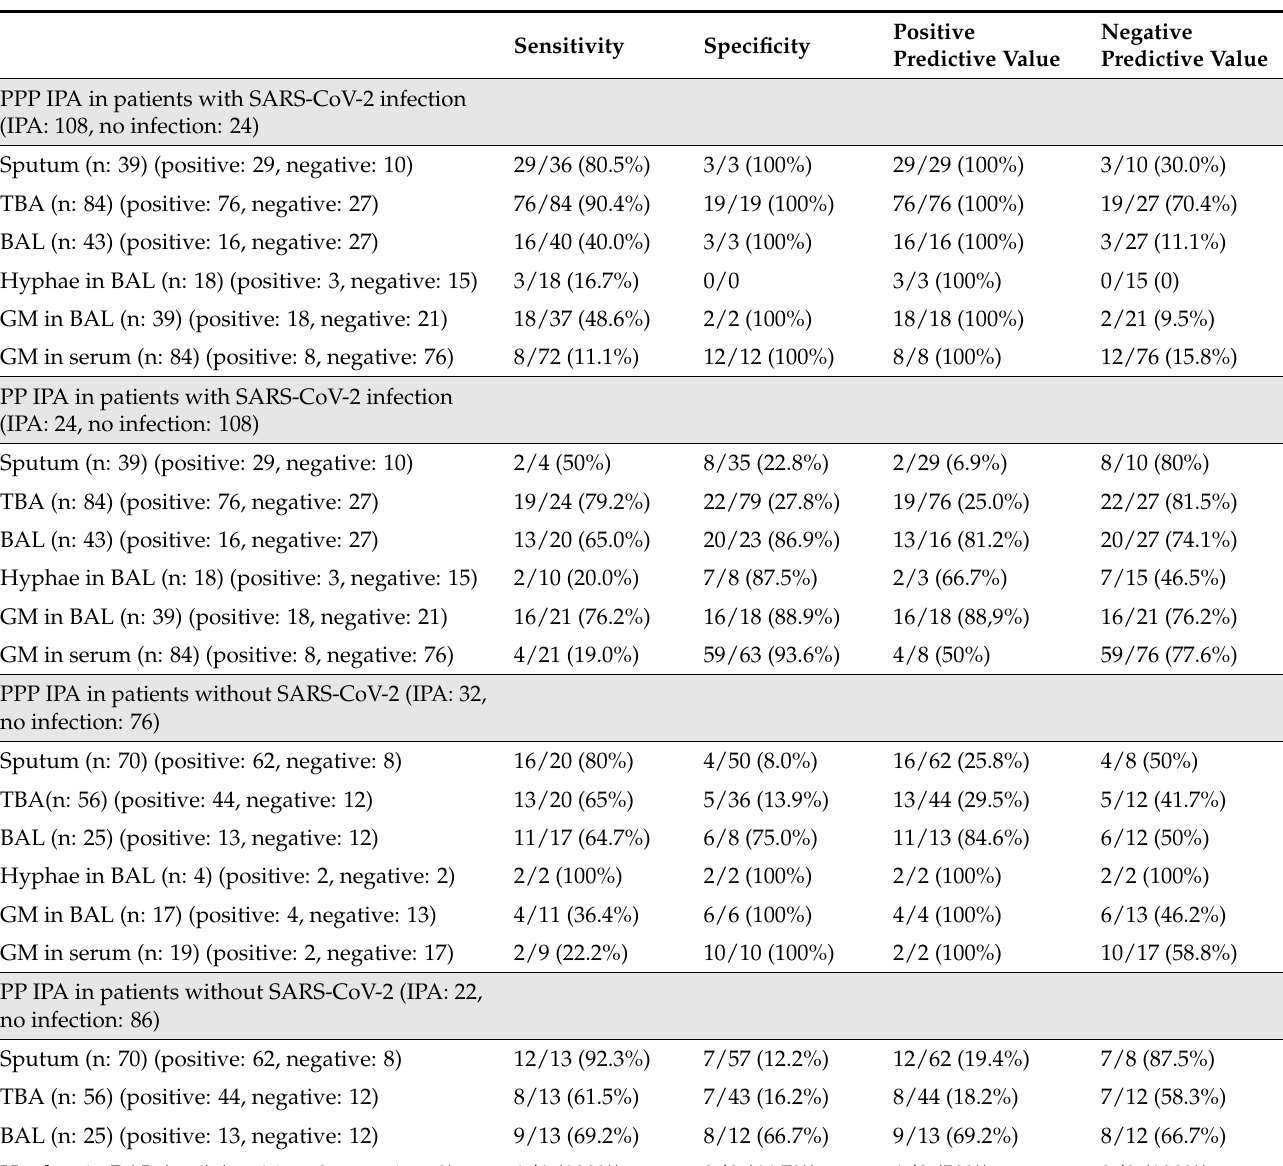
Positive Predictive Value